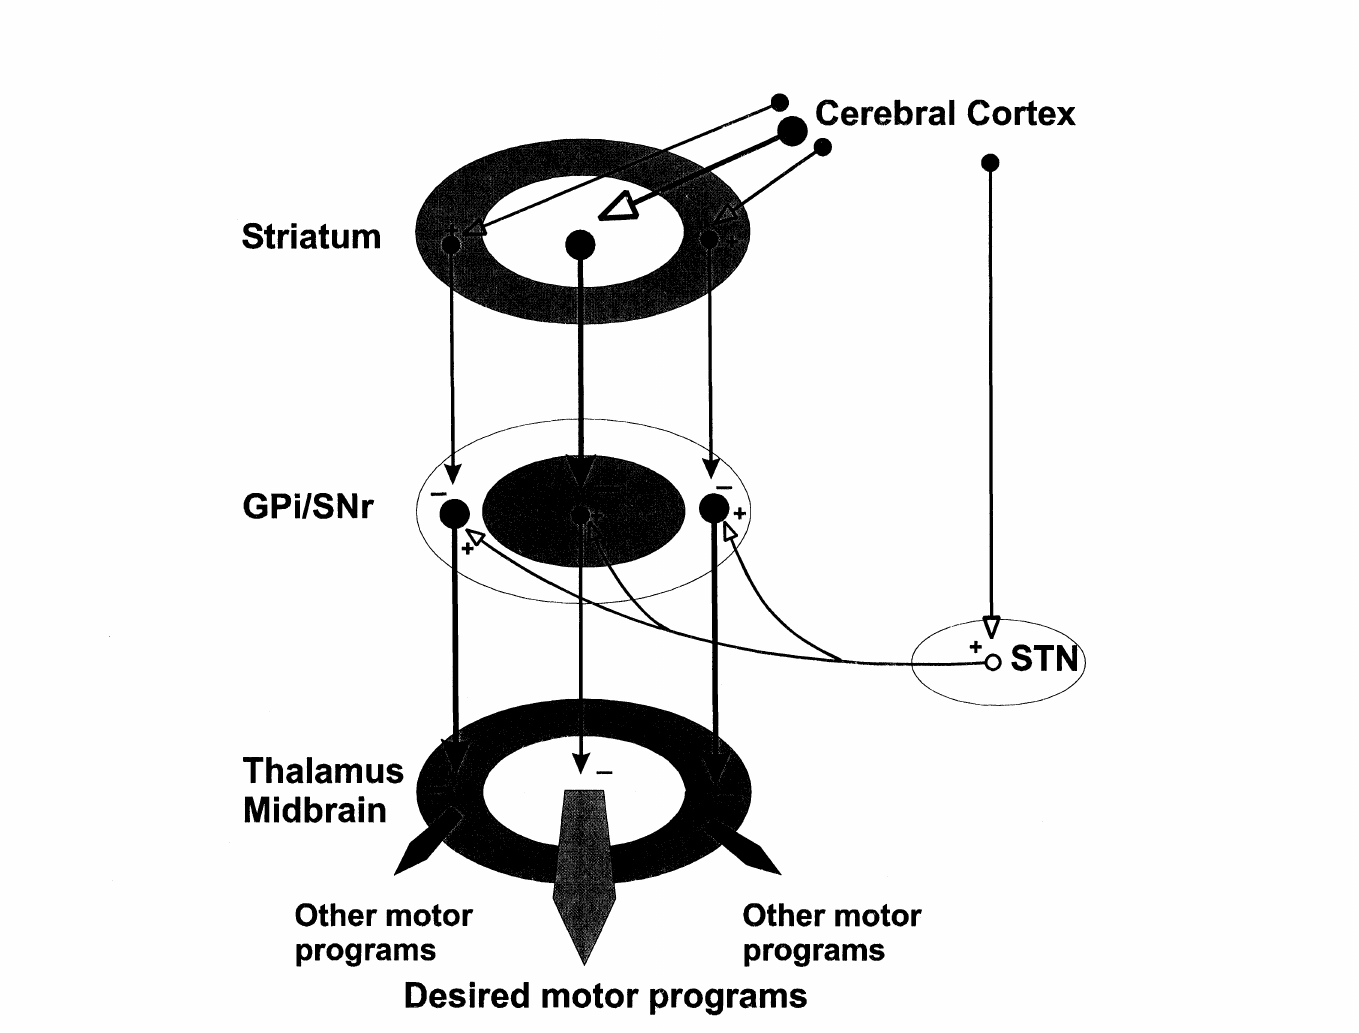
Fig. 4: Schematic representation of the interactions between the cortex cerebri, the striatum, the internal segment of the globus pallidus (GPi) or the reticular part of the substantia nigra (SNr) and the subthalamic nucleus (STN) that are hypothesized to lead to the selection of desired motor programs while suppressing other motor programs. Lines representing GABAergic projections have solid arrowheads, those using excitatory neurotransmitters have open arrowheads. Slightly adapted from figure 14 in Mink